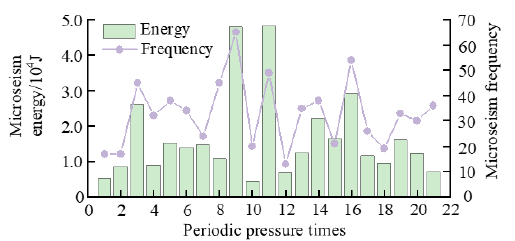
Figure 12. The total frequency and energy distribution of microseism during periodic pressure.